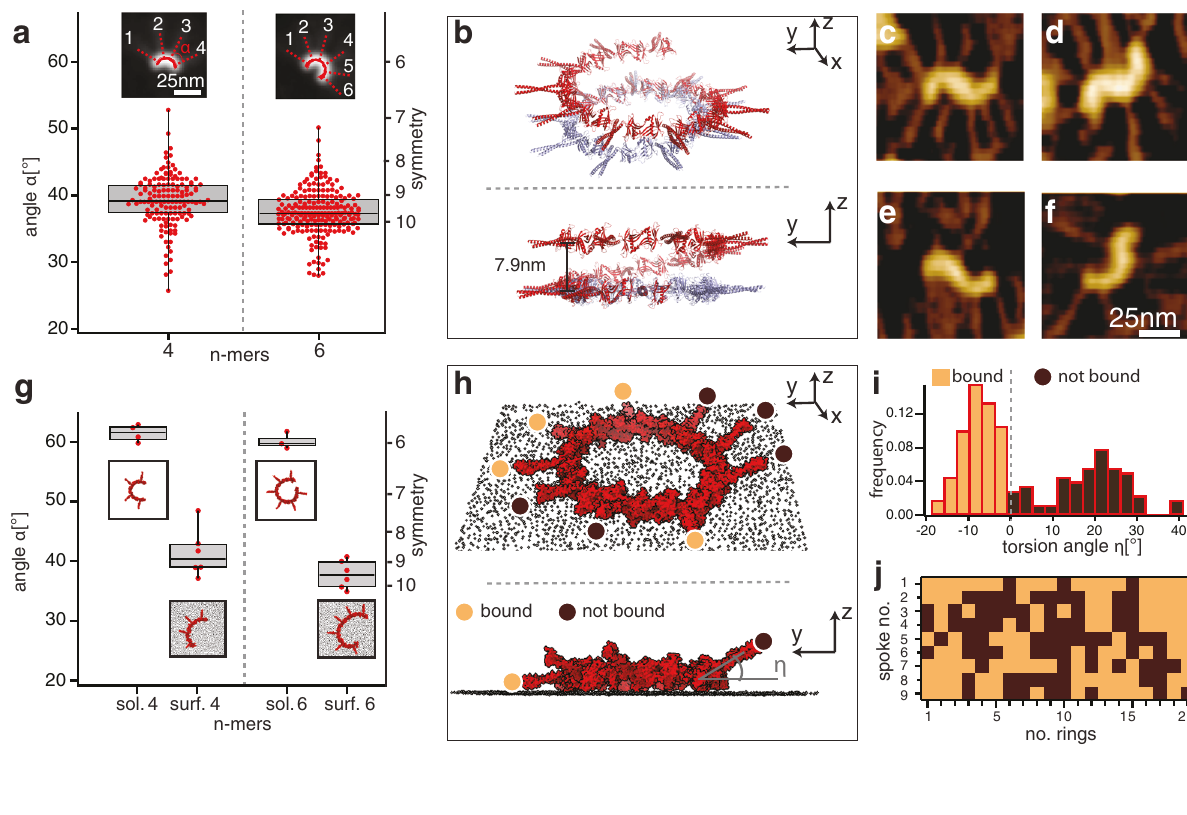
Fig. 5 Surface-guided symmetry of the SAS-6 ring polymer. a Box plot of angle ( α ) distribution of 4- and 6-mers of SAS-6 from PORT-HS-AFM data set (mean ± SD: α 4 = 39° ± 4°, N = 144; α 6 = 38° ± 3°, N = 215). The box shows the upper and lower limits as calculated by the Tukey method and mean, the whiskers extend from the minimum to the maximum of the experimental data. Insets: averaged and realigned images with fi t (solid red line, dashed red lines denote spoke locations). b Isometric (top) and side (bottom) views of 9-mer generated from SAS-6[6HR] crystal structures resulting in a spiral (red); the closed ring (blue) is enforced by modeling 9 . c – f Examples of transient S-shaped SAS-6 oligomers observed with PORT-HS-AFM in N = 5 independent experiments. See also Supplementary Movie 3. g Box plot of in-plane ( α ) angle distribution from MD simulations of SAS-6[HR] 4- and 6-mers in solution and on a surface (the number of simulations for each condition is: for sol 4. N = 4, for surf 4. N = 6, for sol 6 N = 3, for surf 6 N = 6). Insets show examples of corresponding simulated structures. The box shows the upper (75%) and lower (25%) quartiles and median, the whiskers represent upper quartile + 1.5*IQR (inter quartile range) and lower quartile − 1.5*IQR, respectively. h Isometric (top) and side (bottom) view from MD simulation of closed SAS- 6[HR] 9-mer on a surface, with spokes either bound to the surface (beige disks) or not bound (brown disks); only two spokes ’ directions are highlighted in this fashion in the side view. i , j Torsion angle ( η ) distribution of 20 closed SAS-6[HR] 9-mers on a surface simulated by MD ( i ), and corresponding matrix representation ( j ), with spokes classi fi ed as bound or not bound (bound when torsion angle <0, dashed line in i